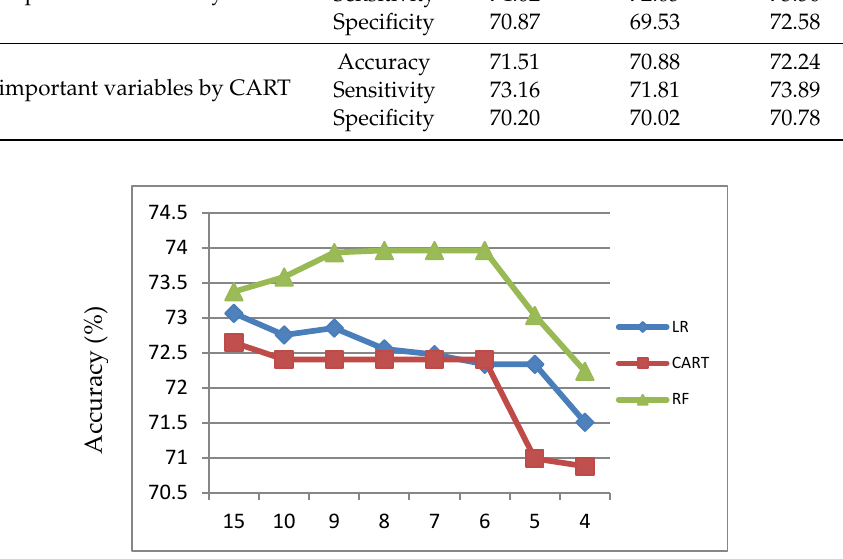
Figure 4. Accuracy of LR, CART and RF with input of important variables identified by CART.